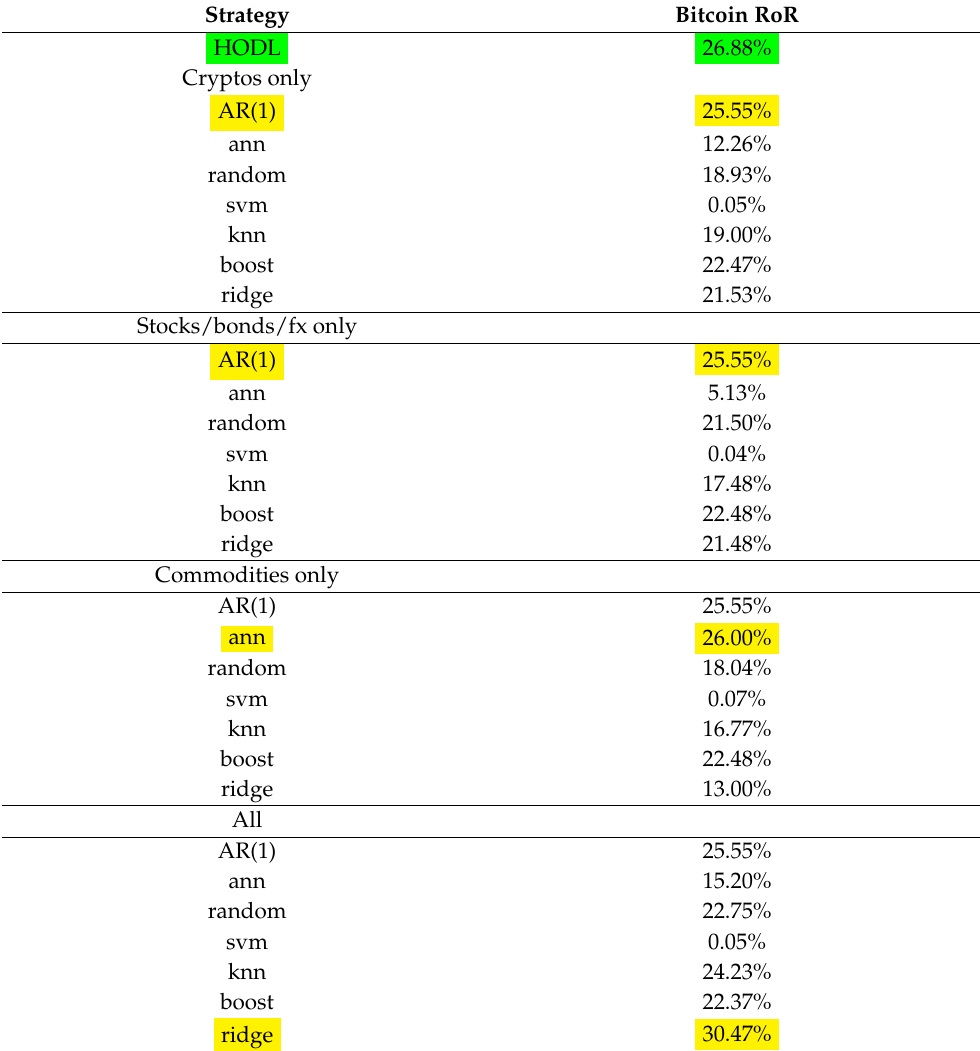
Table 15. Bitcoin Rate of Return (RoR) of ML algorithms against the HODL strategy.